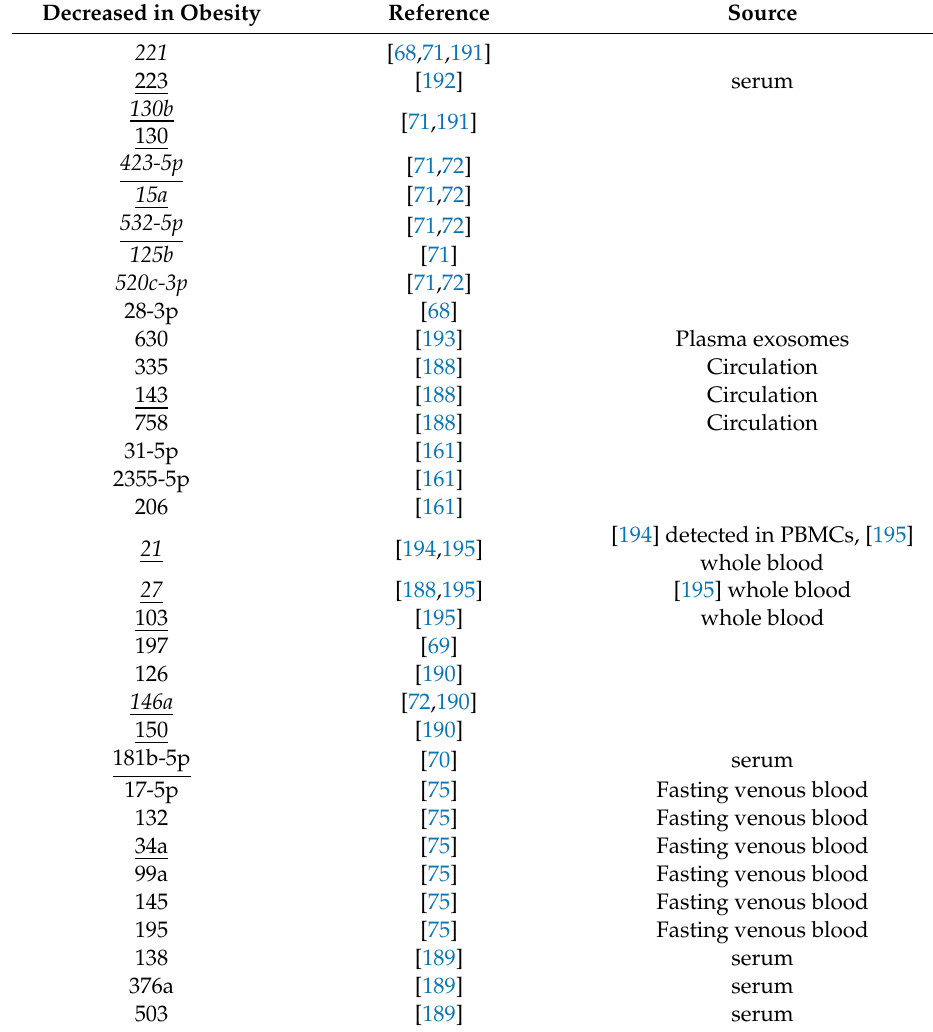
Table A2. Circulating miRNAs decreased in obesity (adapted from [67]). MiRNAs detected in plasma unless otherwise stated in the Source column. Italic text indicates the miRNA was found to be altered in this direction in more than 1 study. Underlined text indicates a contradictory finding where the miRNA was found to be up-regulated in at least one study and down-regulated in at least one other (see Table